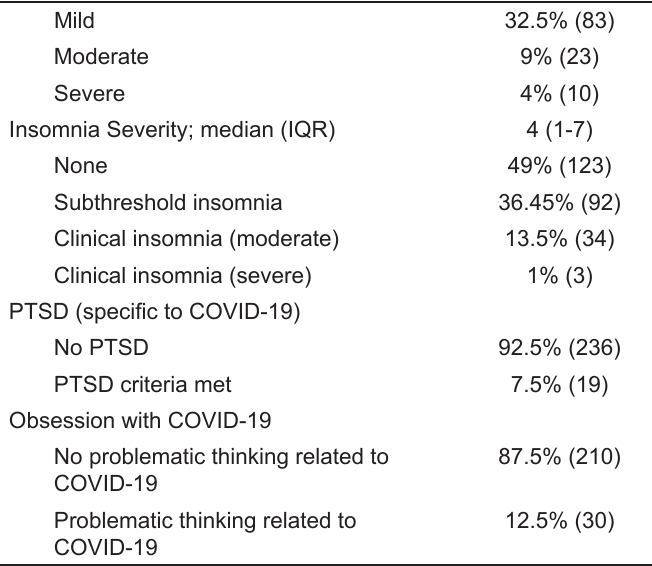
PTSD , post-traumatic stress